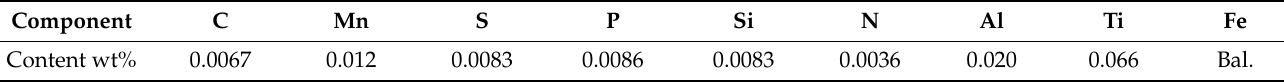
Table 1. Chemical composition of the investigated